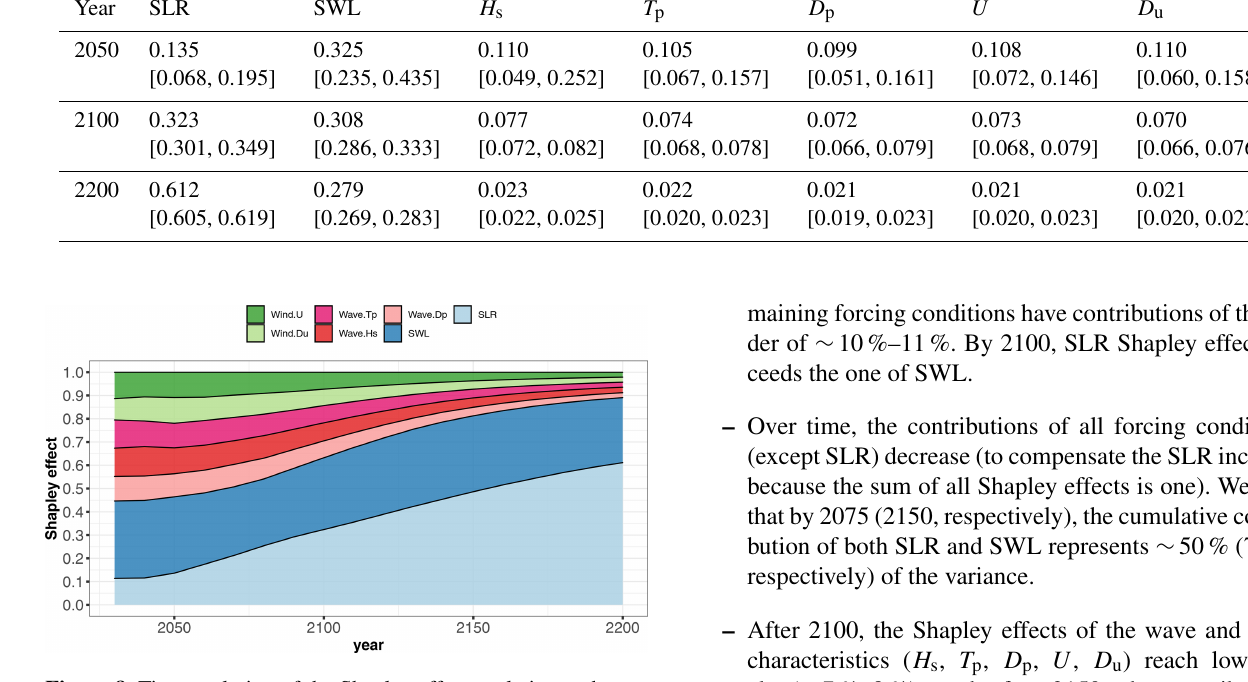
Figure 8. Time evolution of the Shapley effects, relative to the oc- currence of the event { m Y > Y C = 2000m 3 } given SLR projections for the scenario RCP4.5, estimated by computing the median value from B = 50 replicates of the estimation procedure (Sect. 3.5) ac- counting for GP and sampling